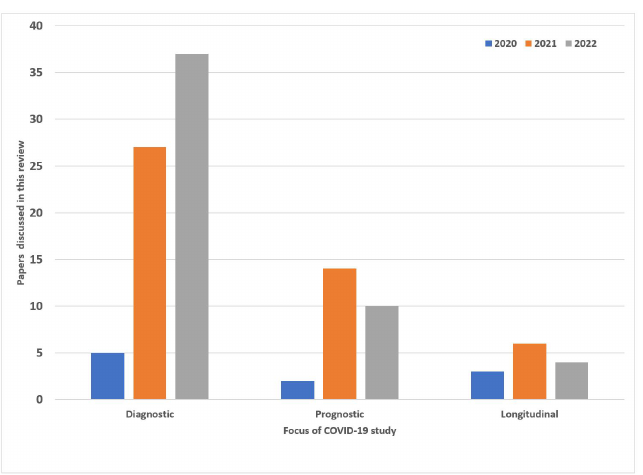
Figure 11. Papers reviewed in this research presented based on the three primary